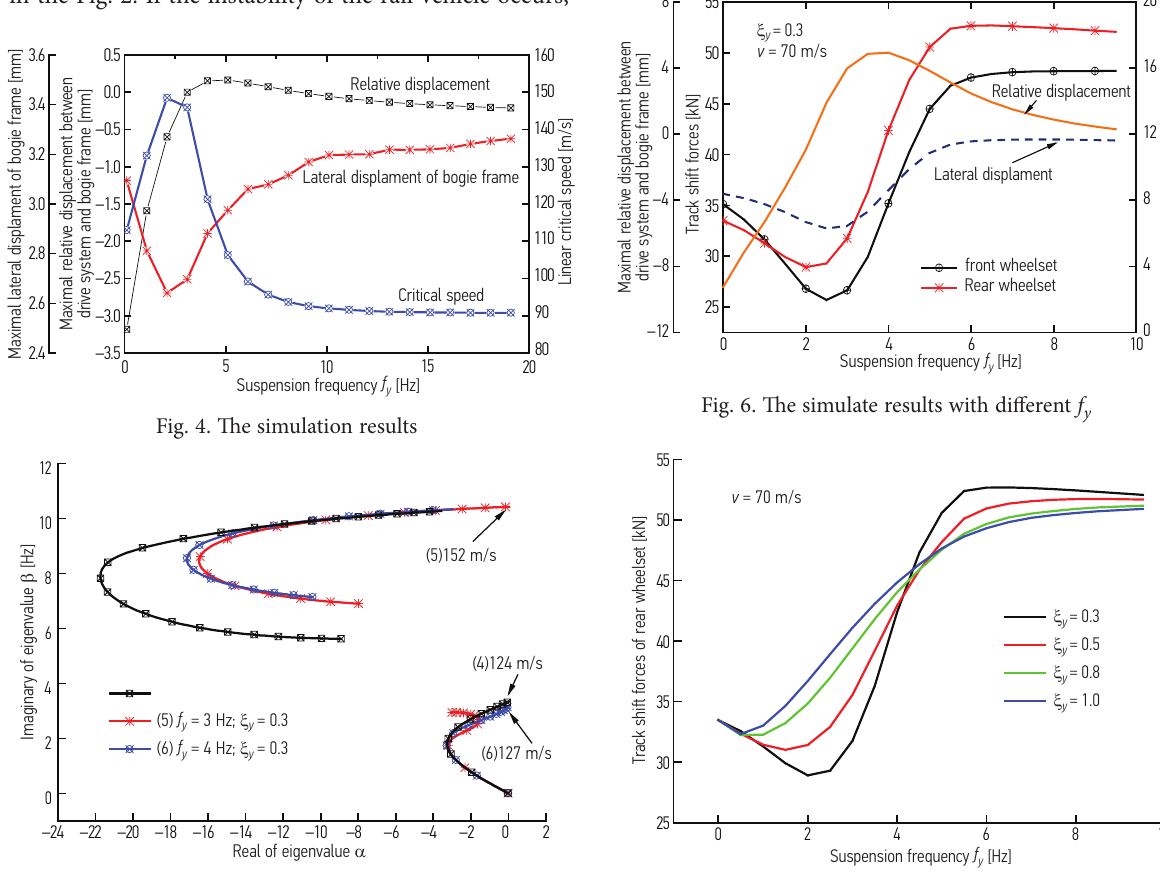
Fig. 5. The root locus curves